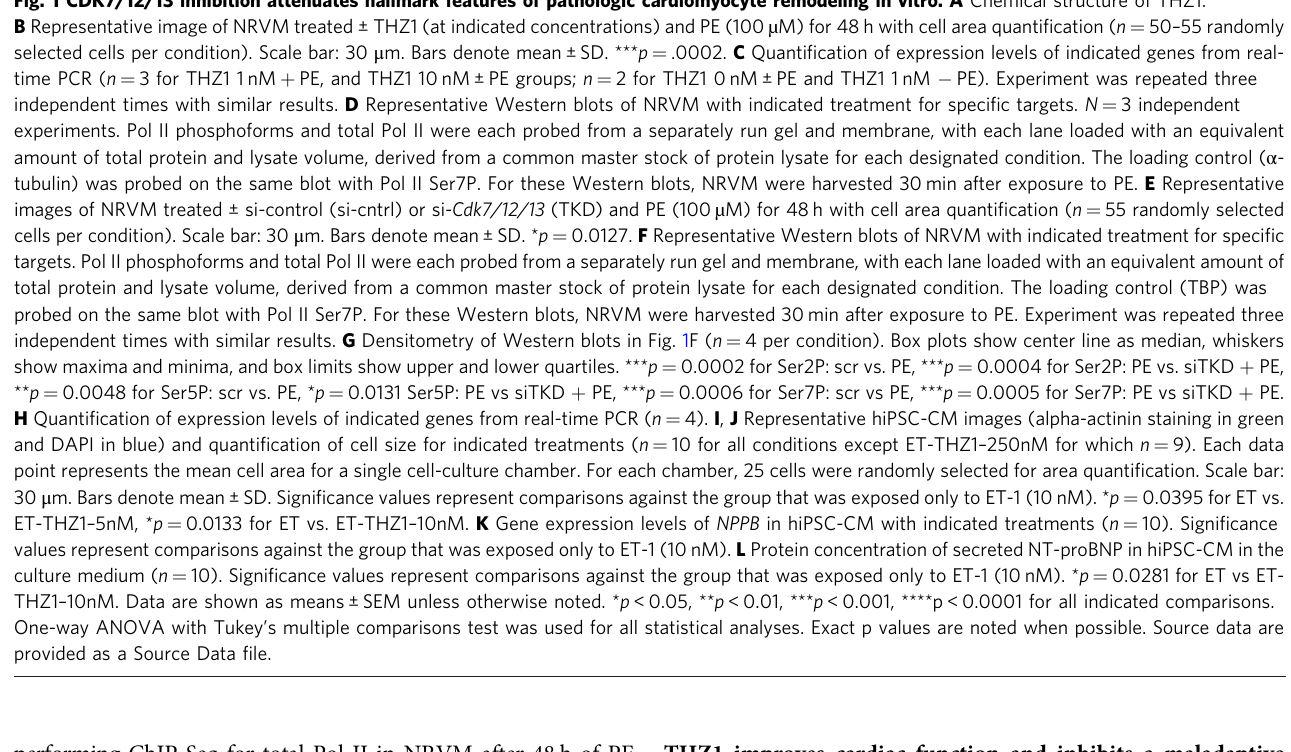
Fig. 1 CDK7/12/13 inhibition attenuates hallmark features of pathologic cardiomyocyte remodeling in vitro. A Chemical structure of THZ1. B Representative image of NRVM treated ± THZ1 (at indicated concentrations) and PE (100 µ M) for 48 h with cell area quanti fi cation ( n = 50 – 55 randomly selected cells per condition). Scale bar: 30 μ m. Bars denote mean ± SD. *** p = .0002. C Quanti fi cation of expression levels of indicated genes from real- time PCR ( n = 3 for THZ1 1 nM + PE, and THZ1 10 nM ± PE groups; n = 2 for THZ1 0 nM ± PE and THZ1 1 nM − PE). Experiment was repeated three independent times with similar results. D Representative Western blots of NRVM with indicated treatment for speci fi c targets. N = 3 independent experiments. Pol II phosphoforms and total Pol II were each probed from a separately run gel and membrane, with each lane loaded with an equivalent amount of total protein and lysate volume, derived from a common master stock of protein lysate for each designated condition. The loading control ( α - tubulin) was probed on the same blot with Pol II Ser7P. For these Western blots, NRVM were harvested 30 min after exposure to PE. E Representative images of NRVM treated ± si-control (si-cntrl) or si- Cdk7/12/13 (TKD) and PE (100 µ M) for 48 h with cell area quanti fi cation ( n = 55 randomly